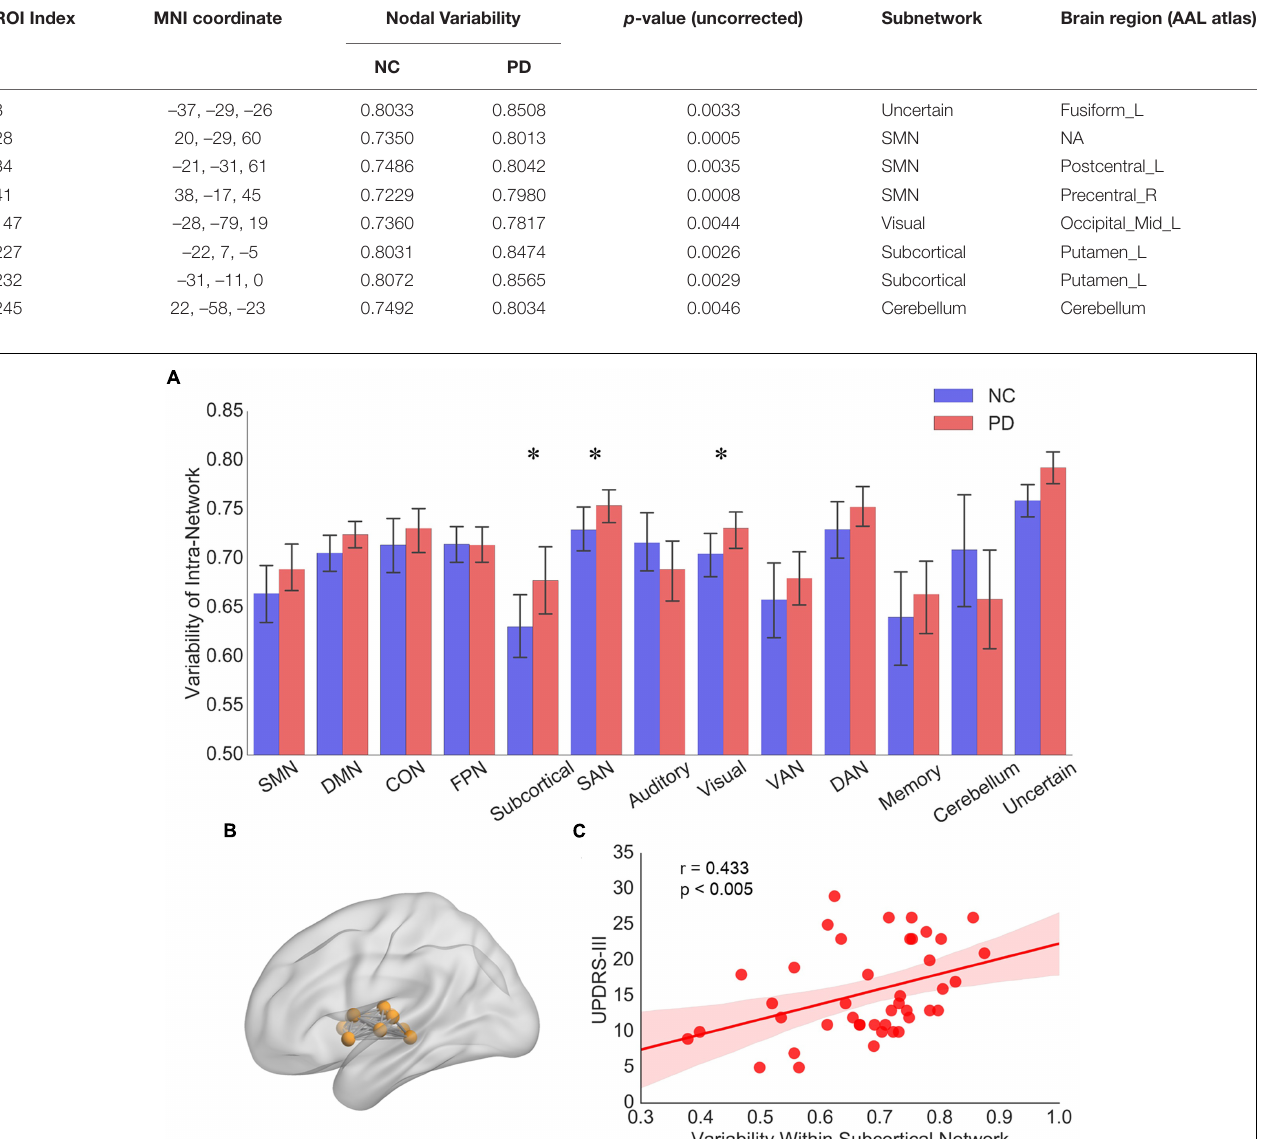
TABLE 2 | Regions showing significant higher nodal variability in PD patients than normal controls.